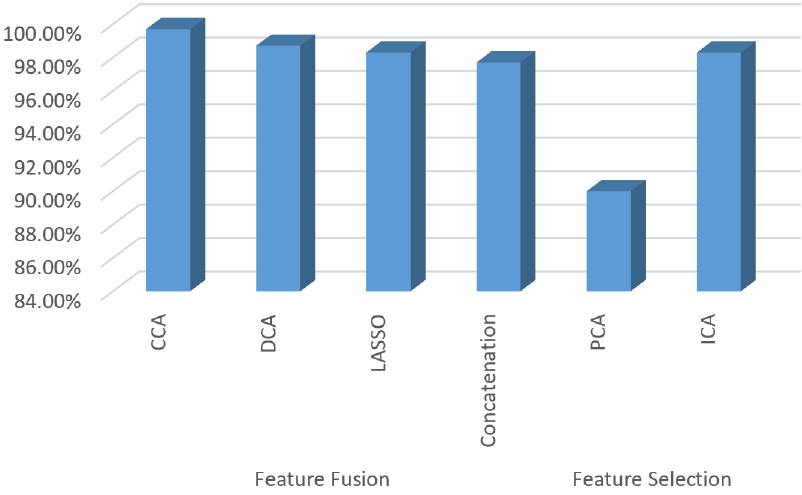
Figure 7. Scatter plot showing the first two independent components and how they discriminant between the four classes. The figure shows the effectiveness of separation between classes after selecting the most representative components using ICA.